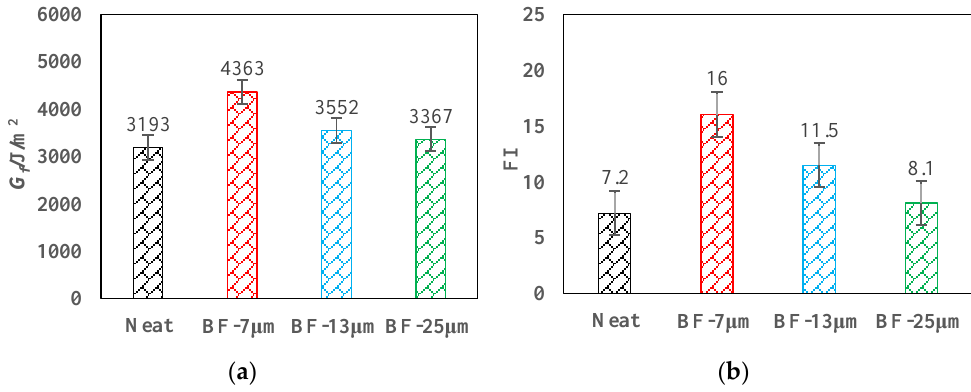
Figure 13. SCB test results: ( a ) fracture energy; ( b ) flexibility index.